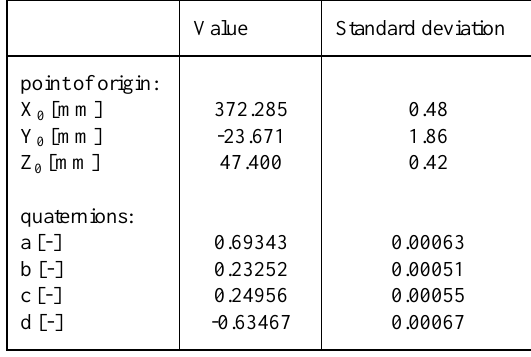
Table 1. Results of the platform calibration: the extrinsic parameters of the laser scanner in the camera coordinate